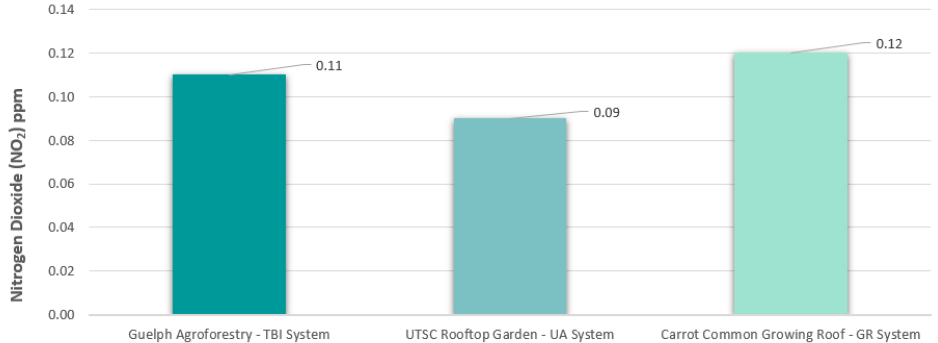
Figure 7. Average nitrogen dioxide (NO 2 ) reduction in parts per millions (ppm) from June to October 2017—Tree-based Intercropping (TBI) System: Guelph Agroforestry Research Station; Urban Agriculture (UA) Systems: UTSC Rooftop Garden; and Green Roof (GR) Systems: Carrot Common Growing Roof.